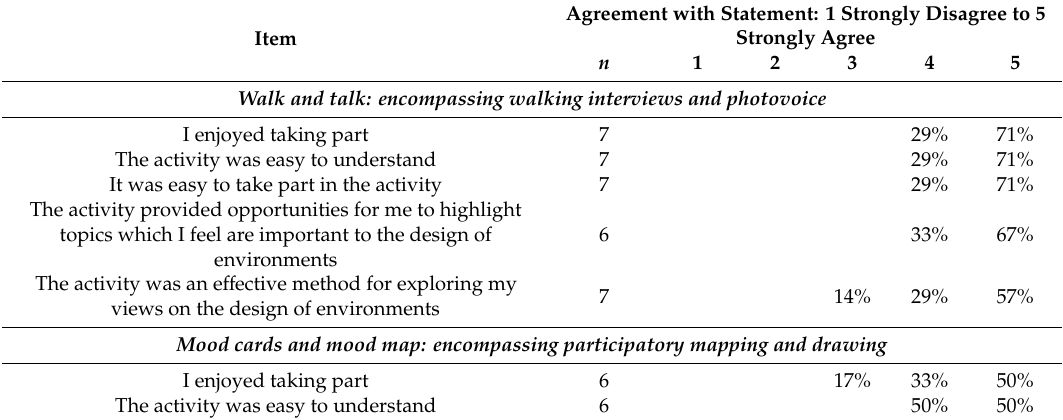
Table 4. Hackney Wick co-design workshop: participant perspectives on engagement techniques. Agreement with Statement: 1 Strongly Disagree to 5 Strongly Item